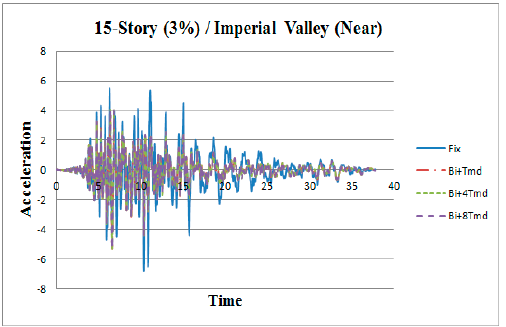
Figure A3. Acceleration time histories for top story of 15-story building under the Kern County (far-fault) earthquake.